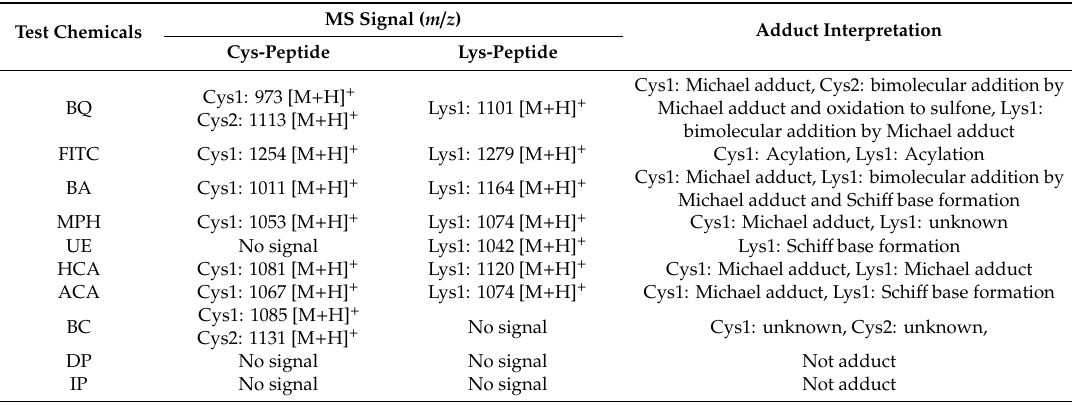
Table 2. Summary of detailed information on peptide